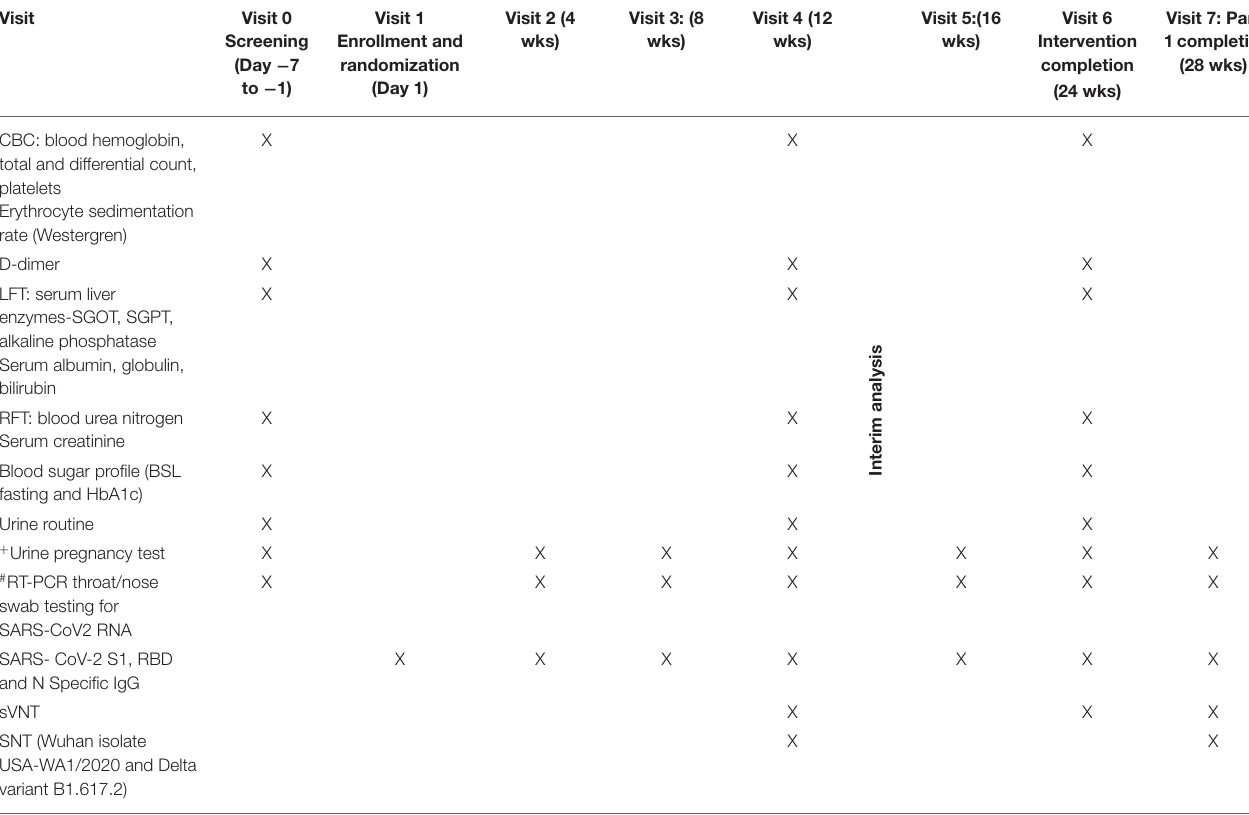
TABLE 2 | Schedule of laboratory investigations. Visit Visit 0